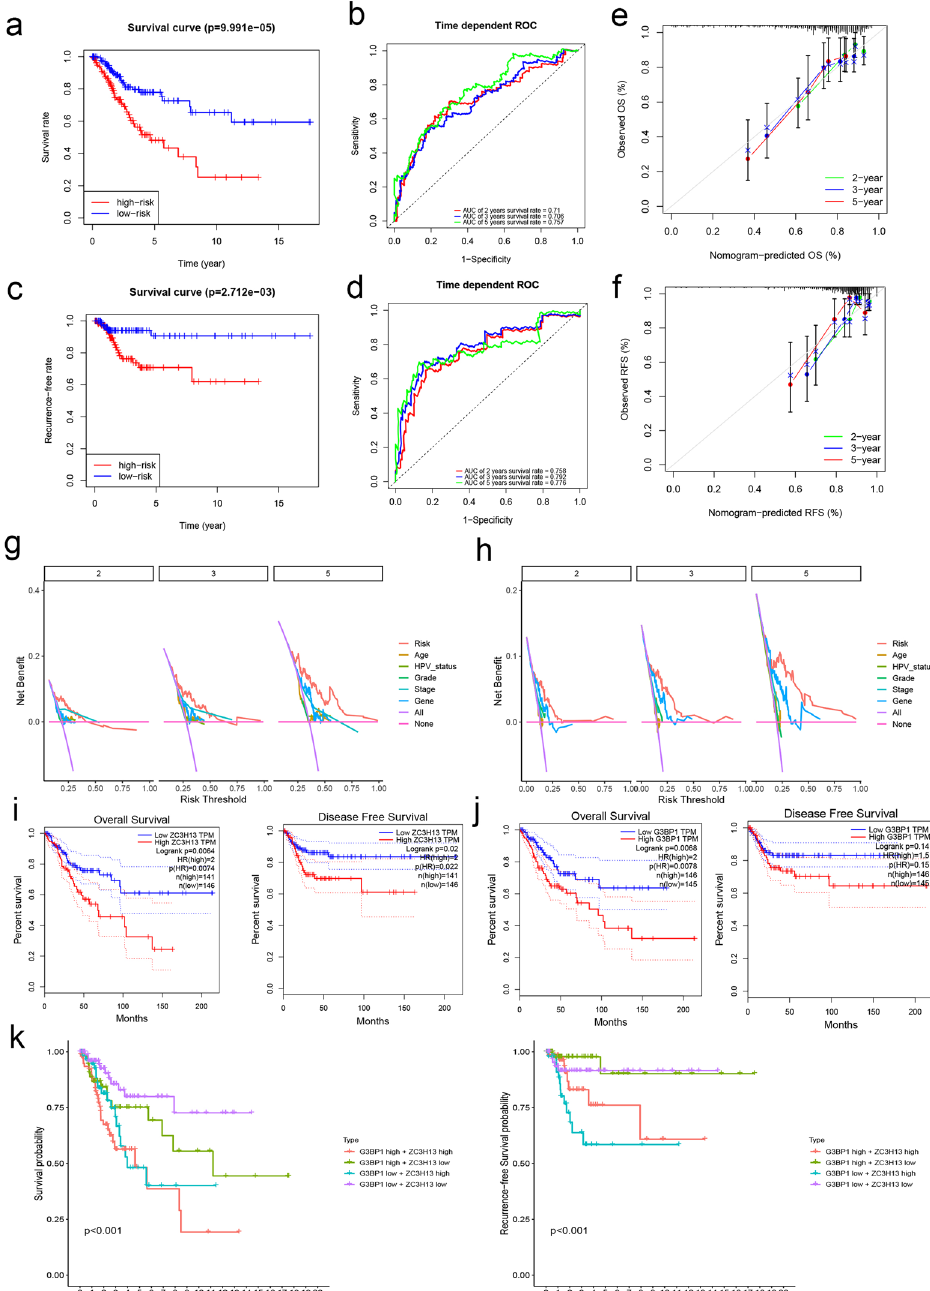
Figure 3. Prognostic model construction and key m 6 A regulators identification. ( a ) The Kaplan–Meier survival curves for CC patients with high- and low-risk. ( b ) ROC curves described the predictive ability of OS-LASSO model for 2-, 3-, and 5-year survival probabilities. ( c ) The Kaplan–Meier survival curves for CC patients with high- and low-risk. ( d ) ROC curves described the predictive ability of RFS-LASSO model for 2-, 3-, and 5-year survival probabilities. ( e,f ) The calibration plots suggested the comparison between prediction and actual outcome for 2-, 3-, and 5-year survival probabilities in the nomogram model for both OS ( e ) and RFS ( f ). ( g,h ) Decision curve analysis for the evaluation of the net benefits of riskscore, Age, HPV_Status, Grade, Genes (ZC3H13 expression) and Stage at 2-, 3-, and 5-year for both OS model ( g ) and RFS model ( h ). ( i ) KM analysis for patients with ZC3H13 different expression level for OS and RFS using GEPIA online tool. ( j ) KM analysis was performed in OS and RFS patients with different expression levels of G3BP1 using the GEPIA online tool. ( k ) Multivariate Kaplan–Meier survival curves for patients with different expression level of ZC3H13&G3BP1, which were selected by LASSO-Cox regression algorithm for OS and RFS